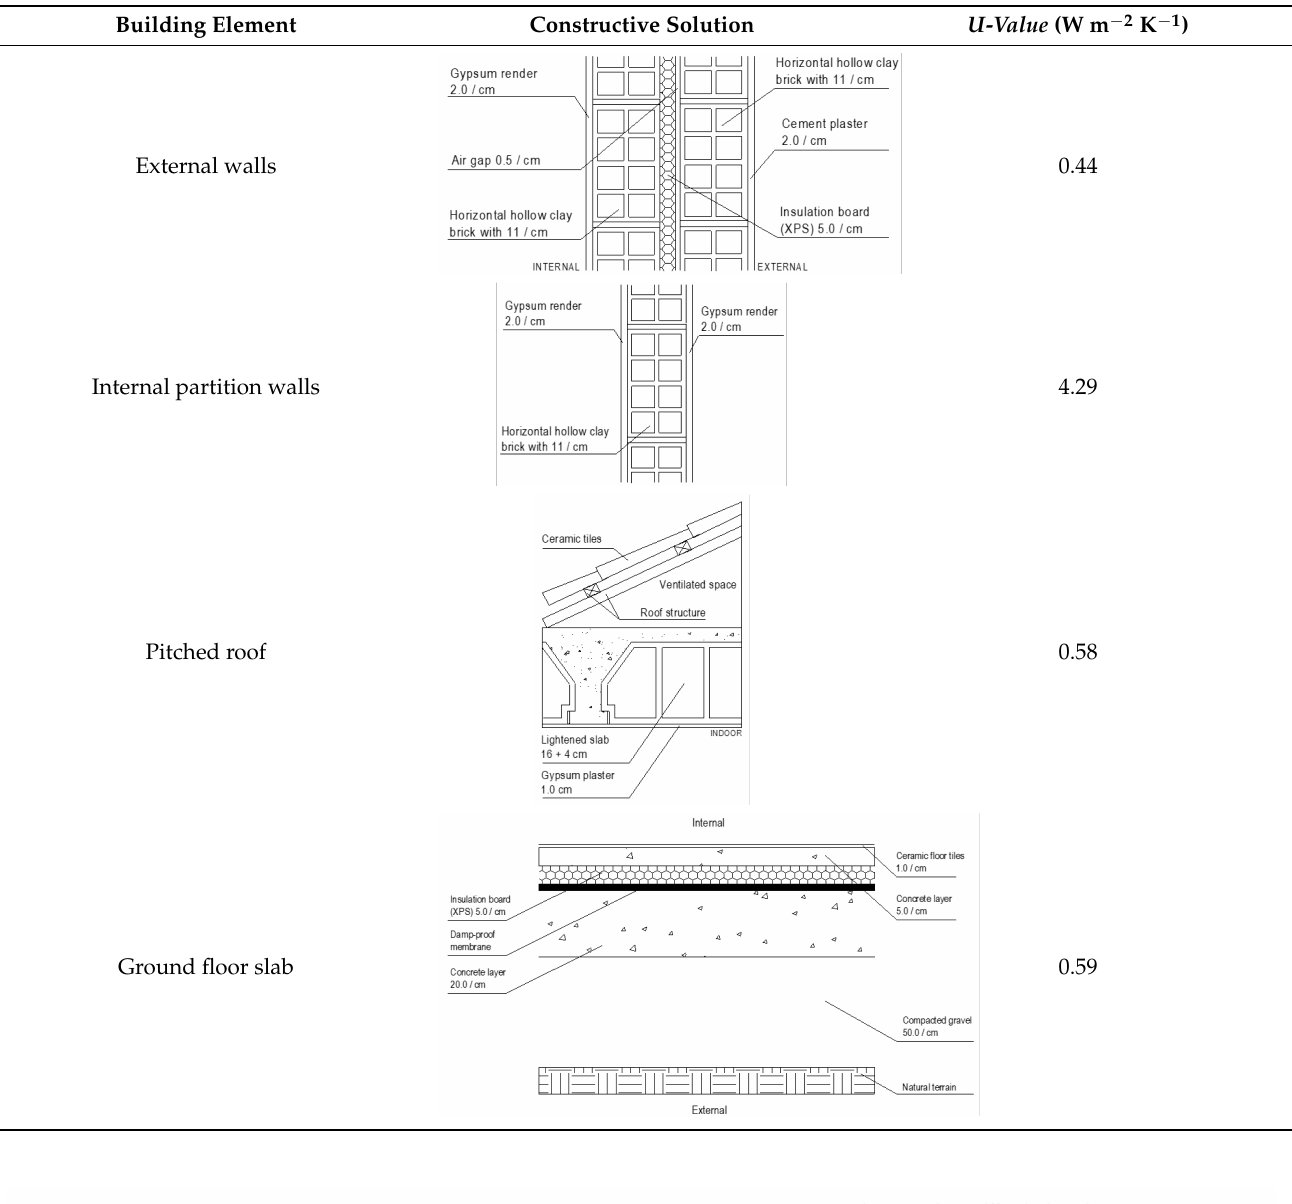
Table 2. Case study constructive solutions.